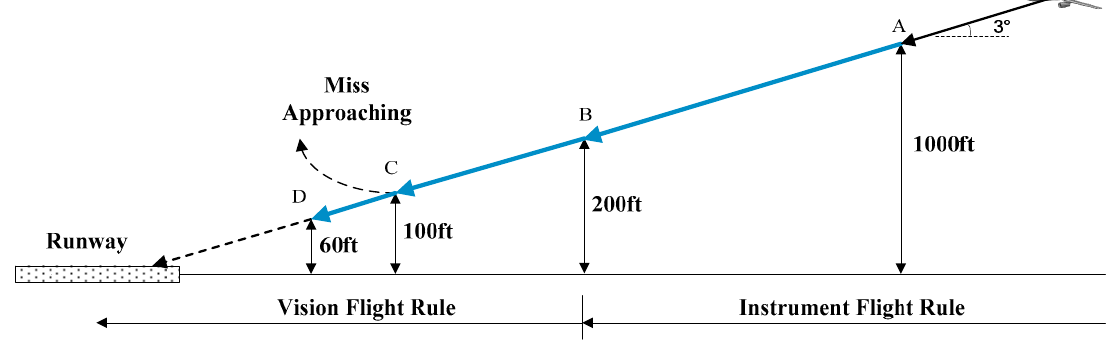
Figure 1. Approach and Landing procedure.